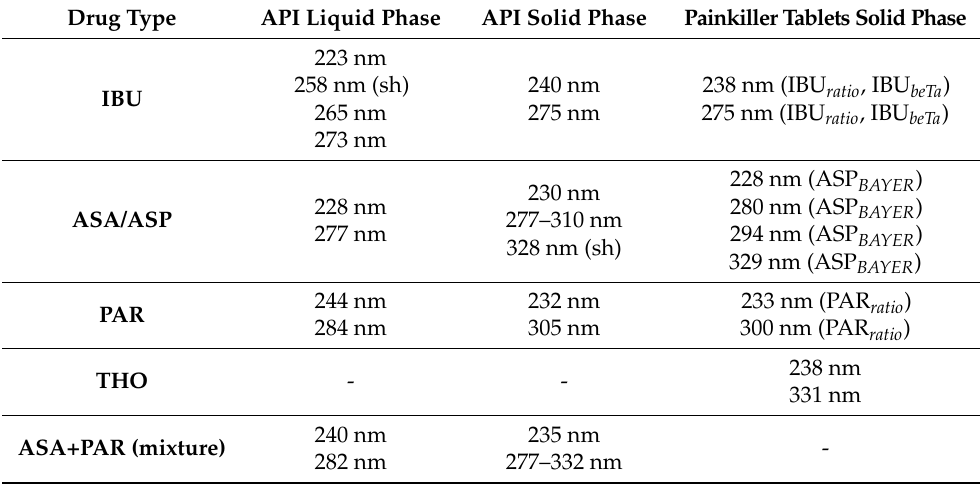
Figure 4. UV absorbance spectra of APIs ibuprofen (IBU), acetylsalicylic acid (ASA), paracetamol (PAR) and a mixture of acetylsalicylic acid and paracetamol (ASA+PAR) in liquid phase. Table 2. UV band maxima positions of liquid and solid phase samples [11,19,20].